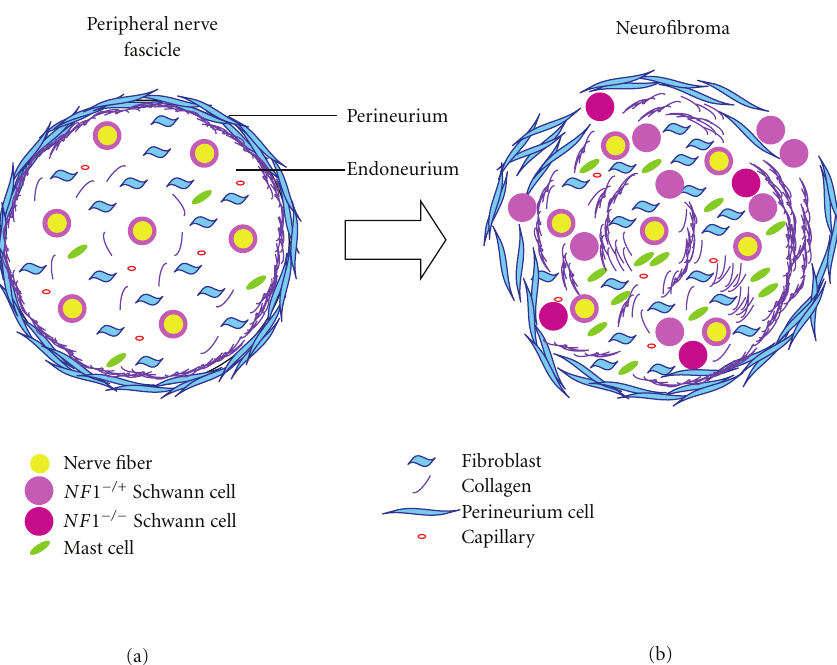
Figure 1: Cellular organization of a normal nerve shaft and a neurofibroma. (a) Nerve shafts are made up of axons and associated Schwann cells. Endoneurium is connective tissue composed by collagen, fibroblasts, mast cells, capillaries and extracellular matrix. Collagen fibers are tighter and more compact near the perineurium. The perineurium is composed by flattened fibroblasts, collagen and elastic fibres. (b) In a neurofibroma, the cells are the same as in a normal nerve shaft, but increased in number. There are more Schwann cells and they can be dissociated from axons. Two kinds of Schwann cells can be detected: NF1 + / − and NF1 − / − . Fibroblasts and mast cells are also increased in number but they are all heterozygous ( NF1 + / − ). The collagen deposits are also increased and perineurium is usually disrupted.